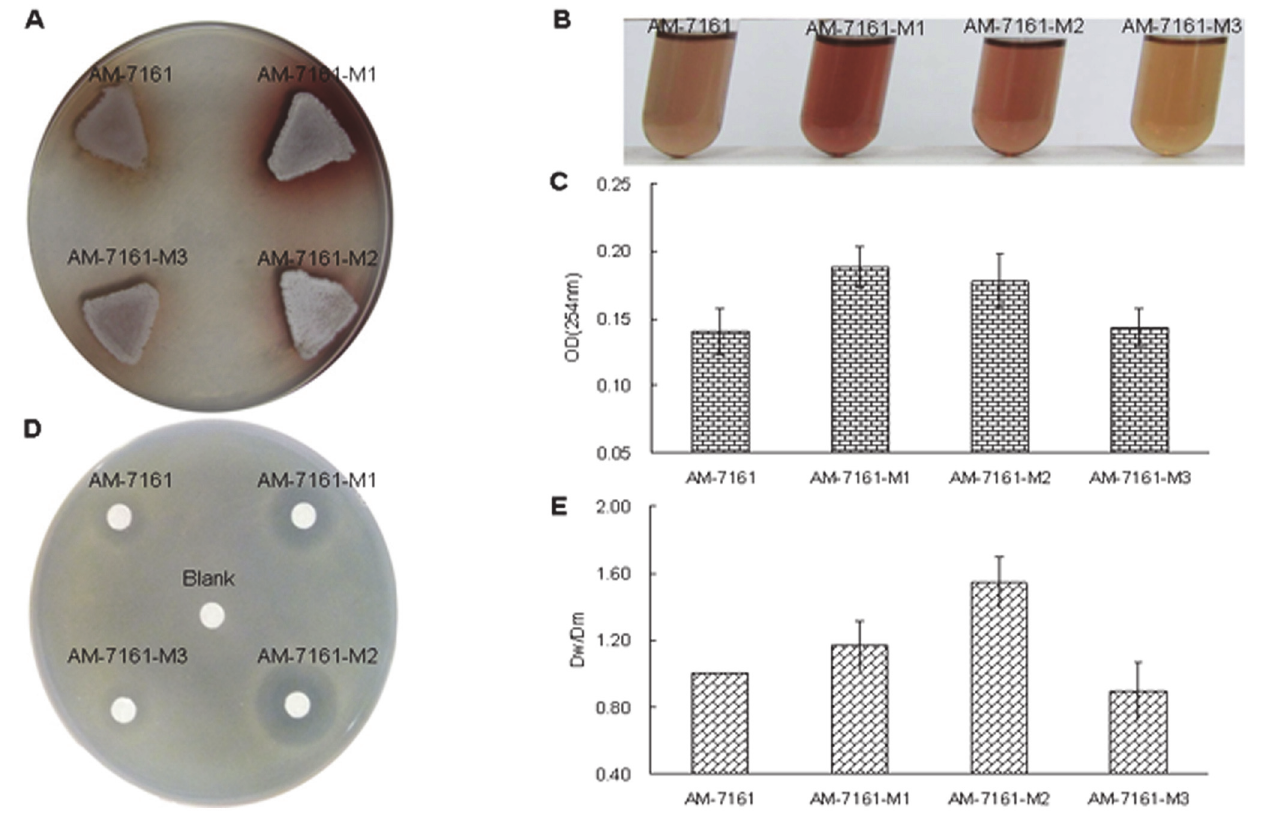
Fig 5. Comparison of pigmentation and bioassay between the wild type AM-7161 and mutant strains. (A) and (B) Pigmentation of AM-7161 and mutant strains on solid and liquid R4 medium. (C) Absorbance values at 254 nm of crude extracts from AM-7161 and mutant strains. (D) Plate assay of antimicrobial activity of AM-7161 and mutant strains against S. epidermidis ATCC 35984. EtoAc is used as blank control. (E) The ratio of the inhibition zone diameter by mutant strains (Dm) to that of the inhibition zone by AM-7161 (Dw).